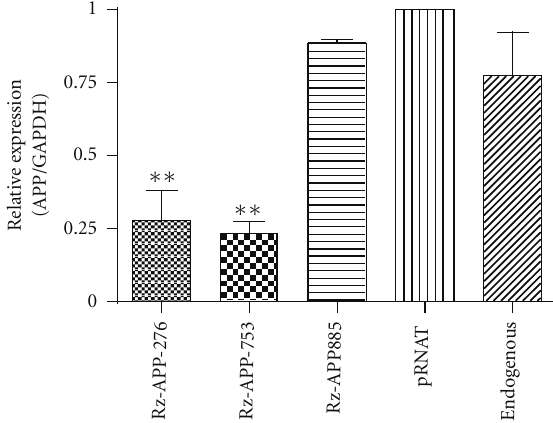
Figure 4: Relative APP mRNA level in HEK-293 cells expressing APP-SOFA-HDV Rz. The expression profile of APP in SOFA-HDV- Rz276-, -Rz753-, -Rz756-, and -Rz885-transfected HEK-293 cells. To assess APP knockdown e ffi ciency at the mRNA level, quantitative real-time PCR was performed with each of the forward and reverse APP or GAPDH primers using the ABI Prism 7000 Sequence Detec- tion System and SYBR Green DNA binding dye (Invitrogen). The specific amplification was assessed based on the dissociation curve profile. The APP gene expression profile was normalized against that of GAPDH. The quantitative PCR procedure was performed in duplicate in three independent reactions for each sample. ∗∗ P < 0 . 01. An approximately 70–80% decrease in GAPDH-normalized APP mRNA levels was observed with cells expressing active SOFA- HDV Rz (the most potent Rz). The GAPDH-normalized levels of endogenous APP were not significantly altered in the untreated or empty vector-transfected control